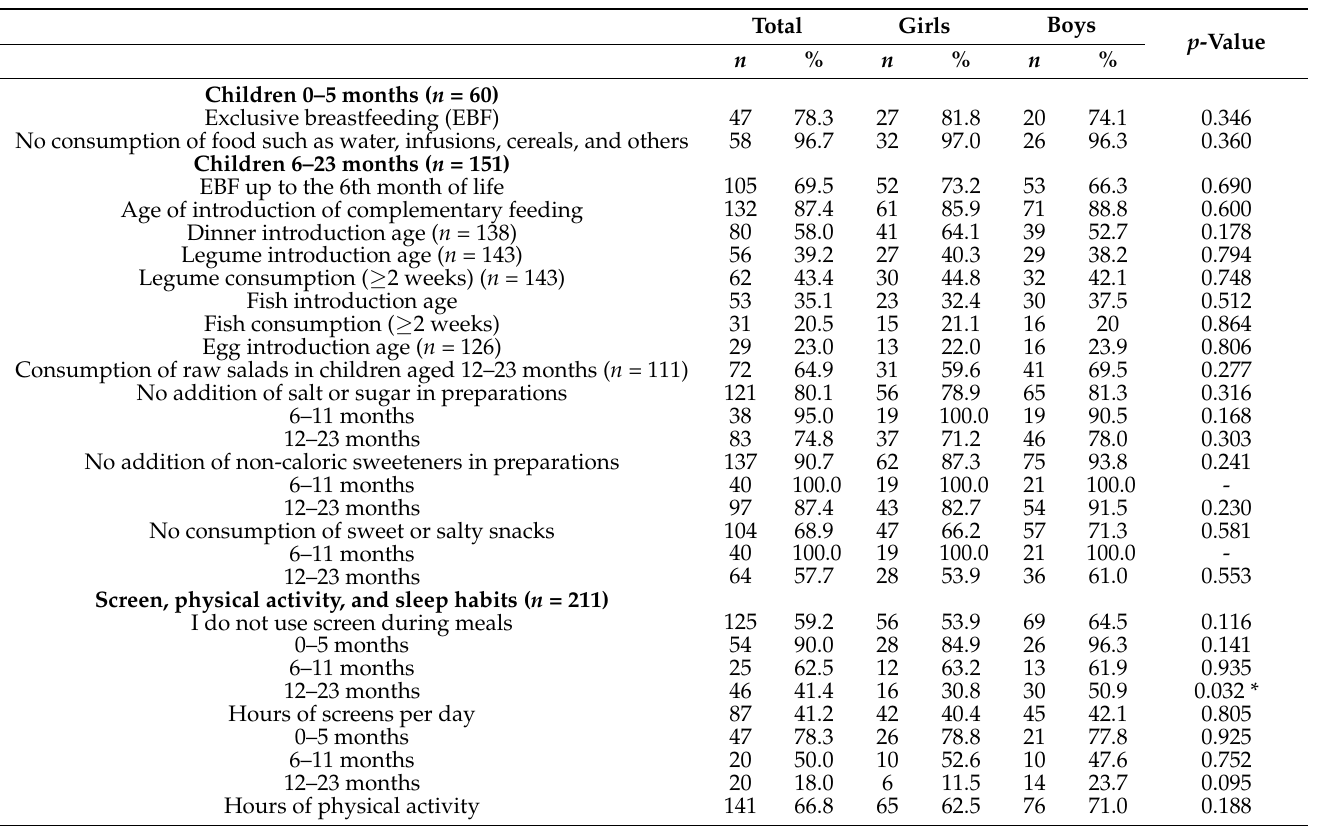
Table 2. Compliance with lifestyle recommendations according to sex in children between 0 and 23